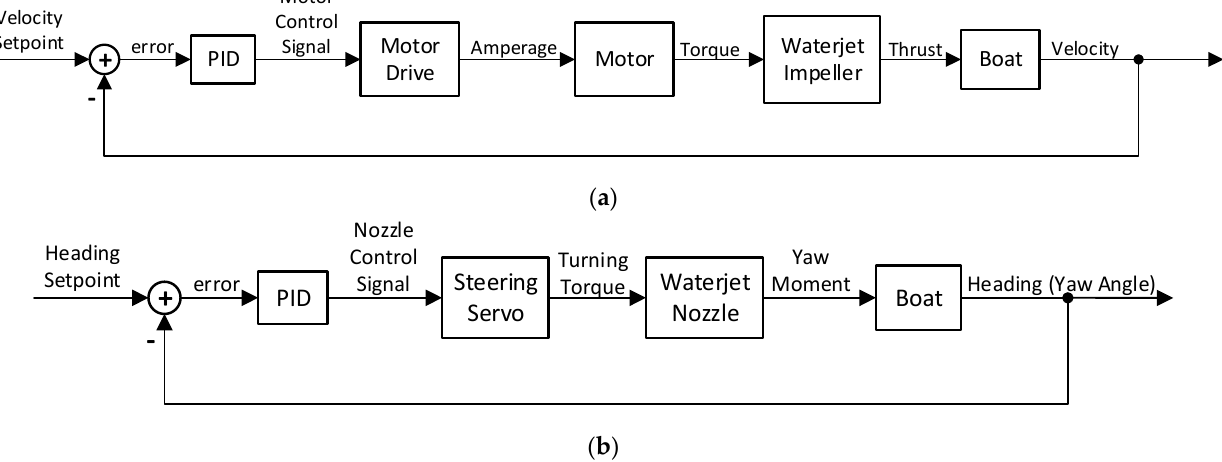
Figure 2. Control loops formed for the vessel. ( a ) Loop for velocity control; ( b ) Loop for heading control.